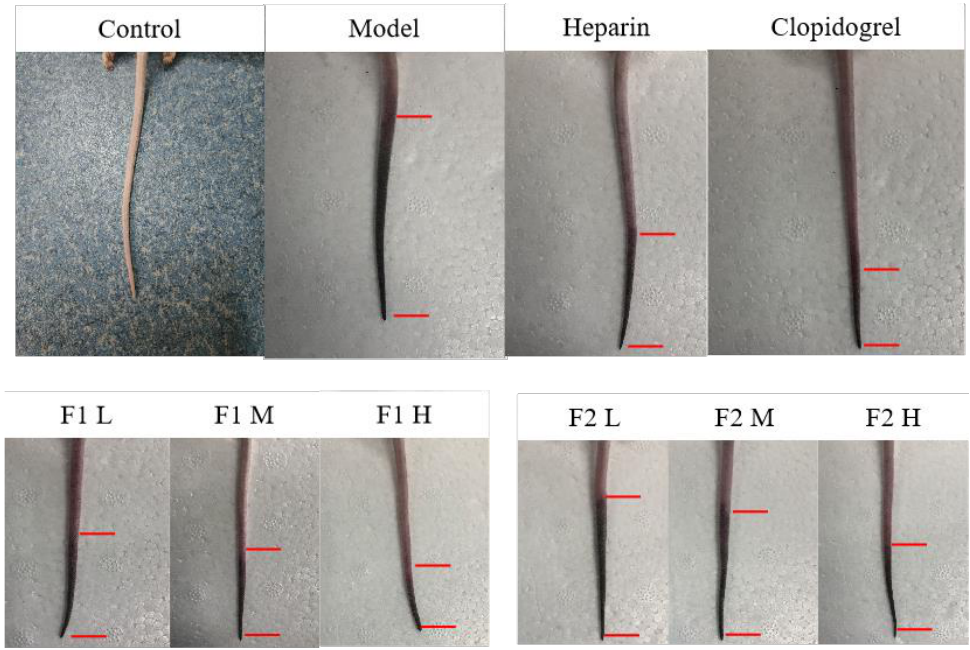
Figure 8. Effects of heparinoid F1 and F2 on carrageenan-induced thrombosis in mice.